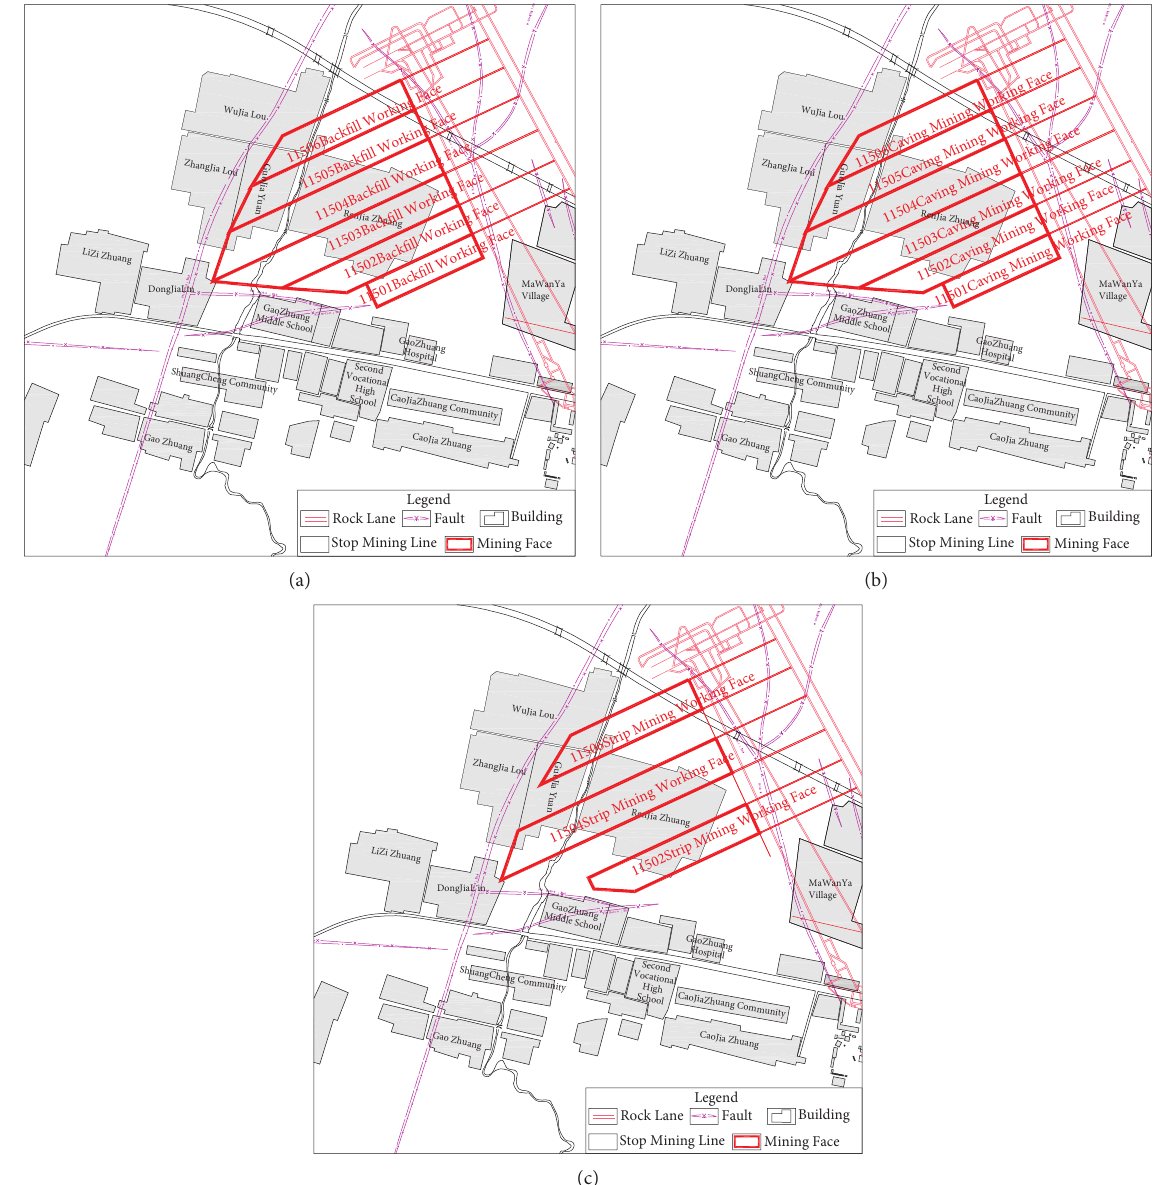
Figure 11: Working face layout of different mining methods. (a) Layout of backfilling mining working face. (b) Layout of caving mining working face. (c) Layout of strip mining working